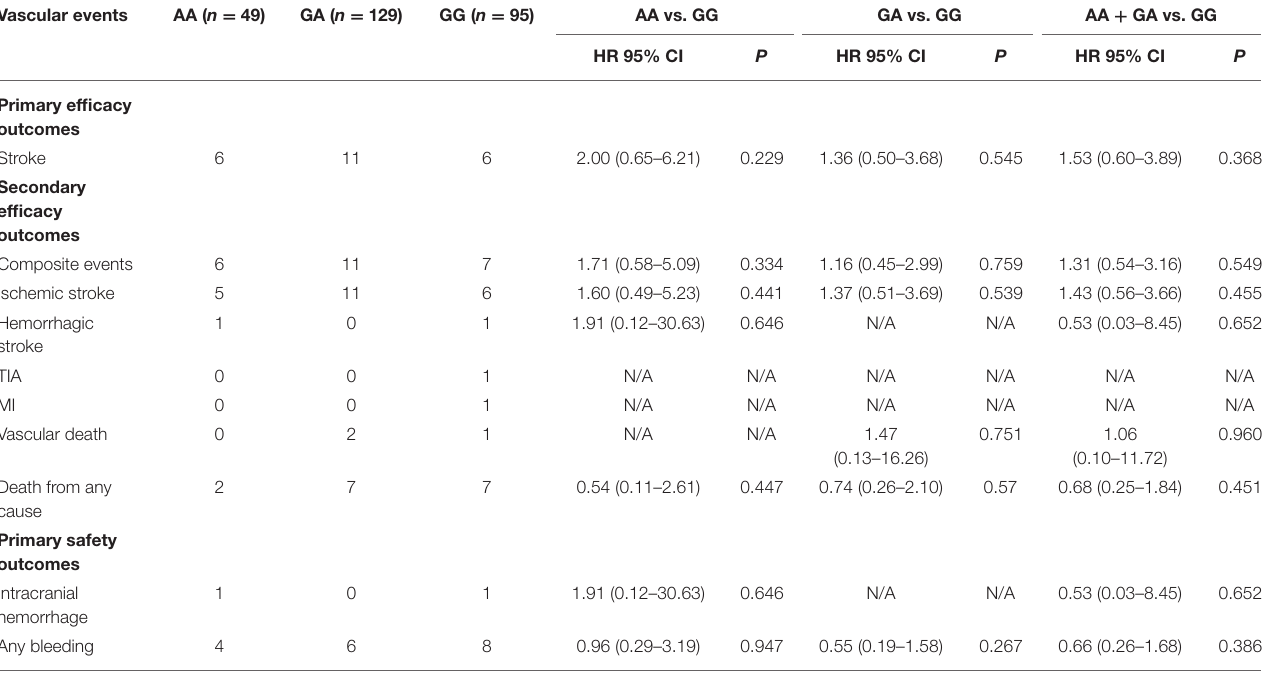
TABLE 2 | Association of PEAR1 rs12041331 with cerebrovascular events within 2 years. Vascular